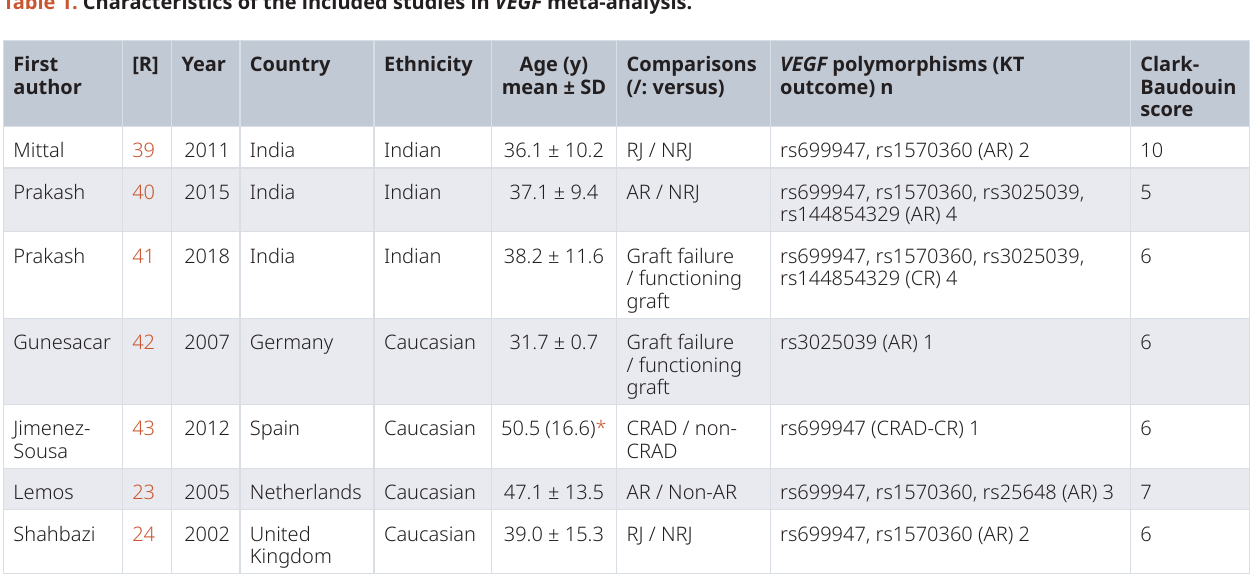
Table 1. Characteristics of the included studies in VEGF